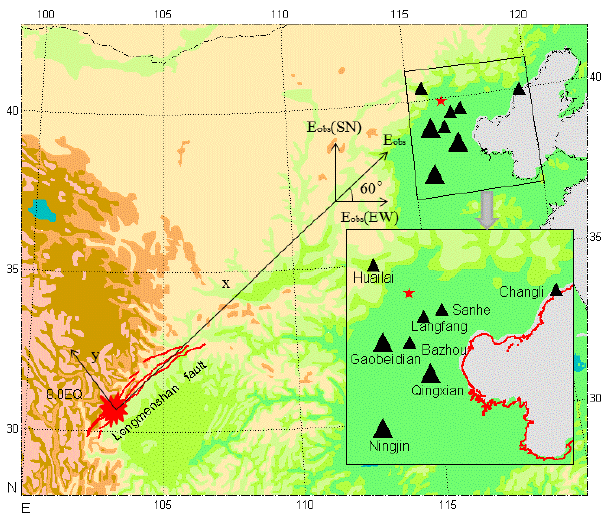
Figure 6. The calculated value of | E x | , expected at the observation location (1440km, 0, 0) due to a dipole source of L = 150km, I = 1 A , f = 1Hz, and d = 19km (Fig. 1), as a function of the typical crustal material’s conductivity σ both in the Earth–air model (red line) and the Earth–air–ionosphere model (blue dotted